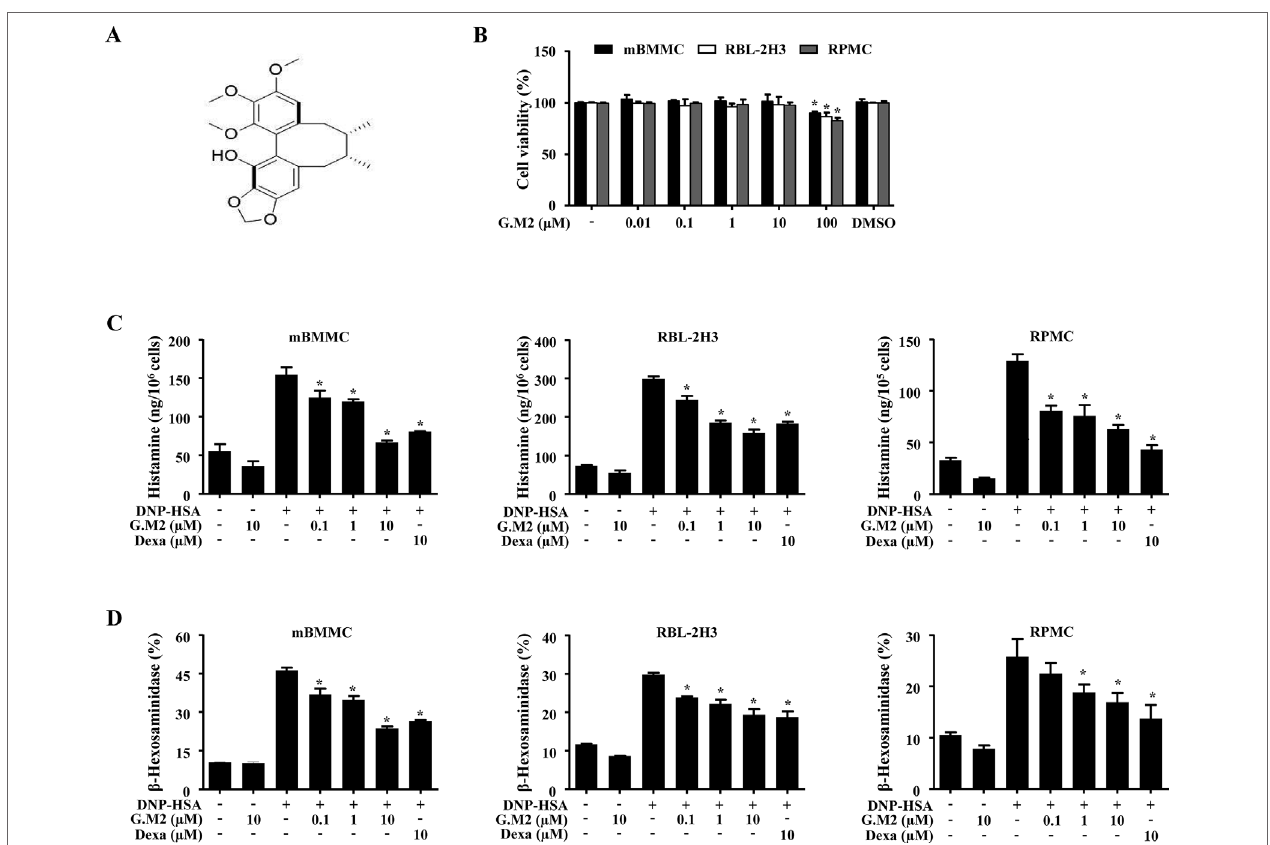
FIGURE 1 | Effects of Gomisin M2 (G.M2) on mast cell degranulation. (A) Chemical structure of G.M2. (B) Mouse bone marrow derived mast cells (BMMCs), rat basophilic leukemia cells (RBL-2H3), and rat peritoneal mast cells (RPMCs) (2 × 10 4 cells/well in a 96-well plate) were pre-treated with or without G.M2 and then incubated with MTT. The absorbance was detected using a spectrophotometer. For mast cell degranulation, anti-DNP (50 ng/ml)-sensitized mBMMCs, RBL-2H3 (5 × 10 5 cells/well in 12-well plates), and RPMCs (3 × 10 4 cells/well in a 24-well plate) were pre-treated with or without G.M2 or Dexa for 1 h and then challenged with DNP-HSA (100 ng/ml). (C) Histamine levels were detected with a fluorescence plate reader. (D) The level of β -hexosaminidase was measured using β -hexosaminidase substrate buffer. Each dataset presented as a graph represents the means ± SEM of three independent experiments. * p < 0.05, compared with the DNP-HSA-challenged group. Dexa: